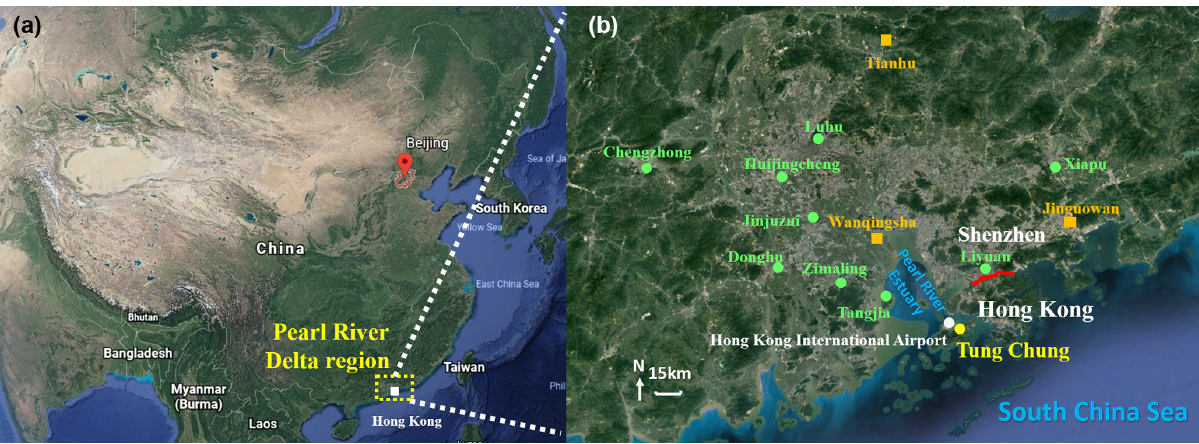
Figure 1. Location of the sampling site (yellow circle) and the surrounding environment. The red line in (b) shows the border between Hong Kong and Shenzhen, Guangdong. The three regional and nine urban air quality monitoring stations in the PRD are denoted by orange blocks and green circles,